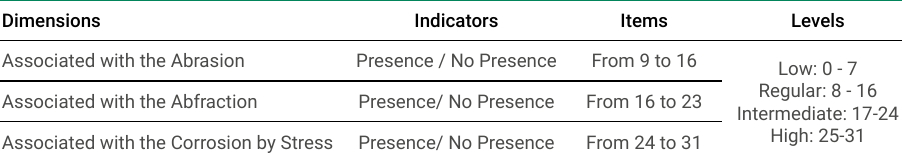
Table 1. Operational definition of the variable Extrinsic Factors